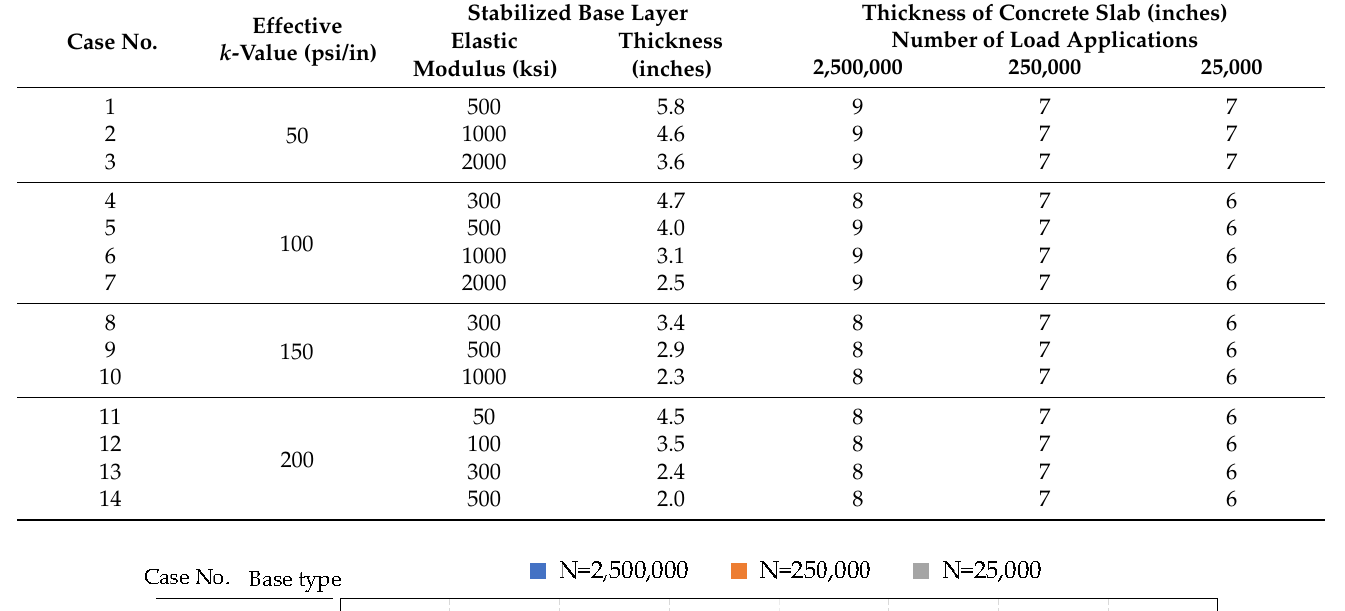
Table 14. Layer compositions of CRCP structures under the combined loading condition (1 in = 25.4 mm, 1 ksi = 6.89 MPa, 1 psi/in = 271 kN/m 3 ).